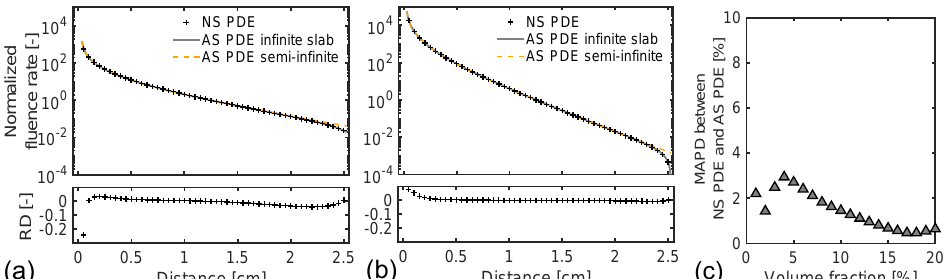
Figure 6. ( a , b ) Fluence rates calculated from the PDE at different positions for the volume fractions of ( a ) 1% and ( b ) 20%. The analytical solutions (ASs) of the PDE (Equation (4)) for the infinite slab and semi–infinite medium are compared with the numerical solutions (NSs). The results are normalized by the values at the SC distance of 1.25 cm ( ( z , l ) = ( 1.25, 0 ) ). The relative differences (RDs) between the NS and AS for the infinite slab are plotted in the each figure’s bottom. ( c ) Mean absolute percentage difference (MAPD), D Φ ( N , P ; A , P ) (Equation (8)), at different volume fractions.